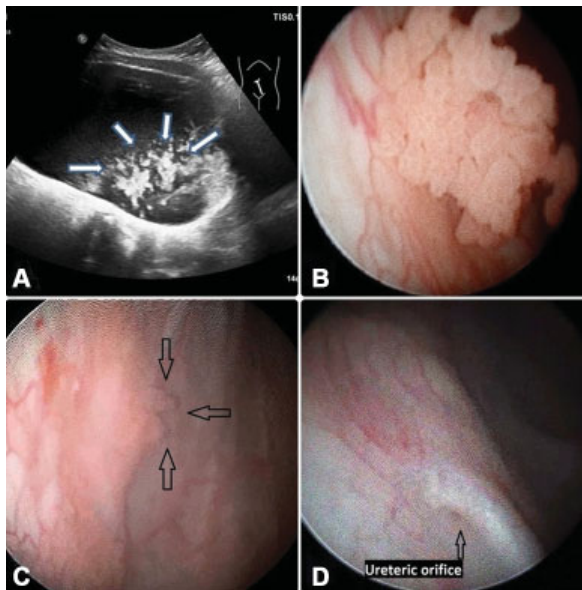
Fig. 2 Next to the ori fi ce of the right ureter, an 18 (cid:1) 20 (cid:1) 21mm large, lobulated, and hyperre fl ective lesion was detected on ultrasound. ( A ) Urethrocystoscopy revealed a classical uroepithelial papilloma next to the right ureteral ori fi ce. ( B ) One month after surgery, the control cystoscopy indicated residual papilloma. ( C ) In the third postoperative month, the control cystoscopy revealed no residual lesion. ( D ) Case